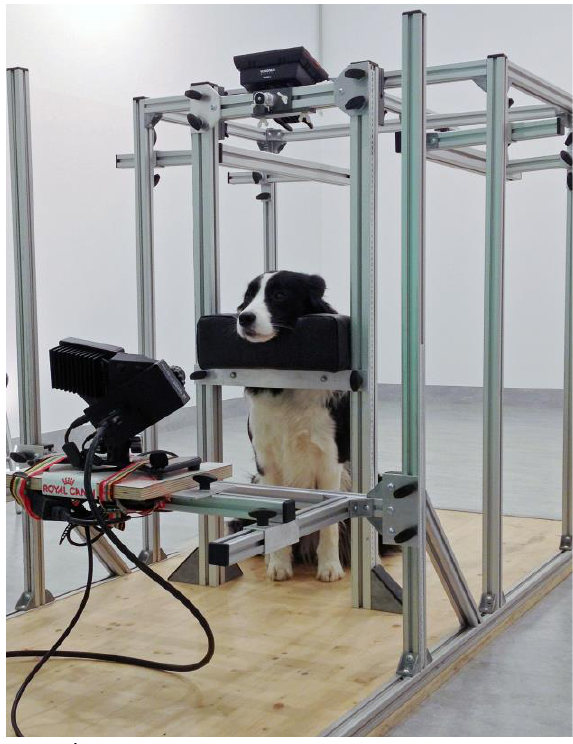
Figure 1 . A dog participant in the chin